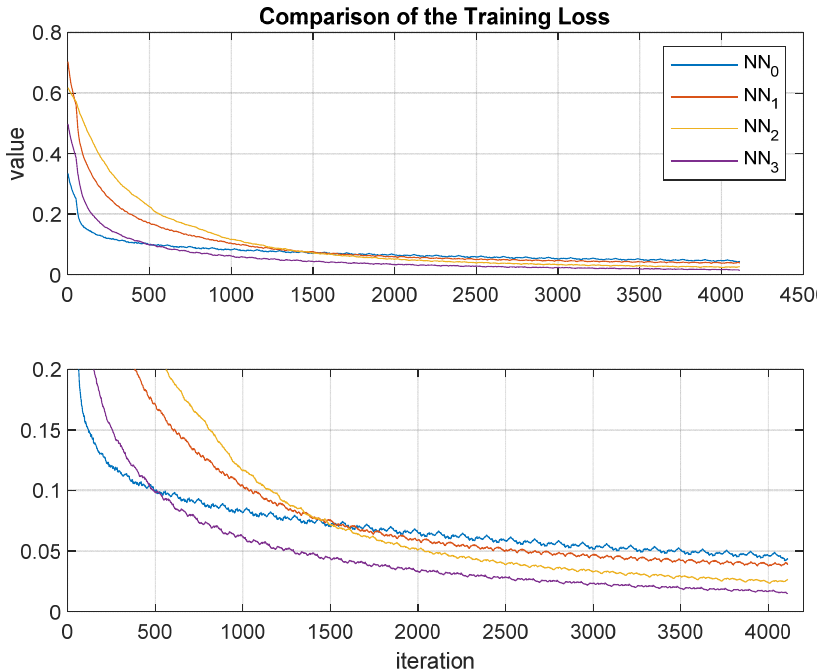
Figure 12. Loss-function behaviors comparison during training phase.